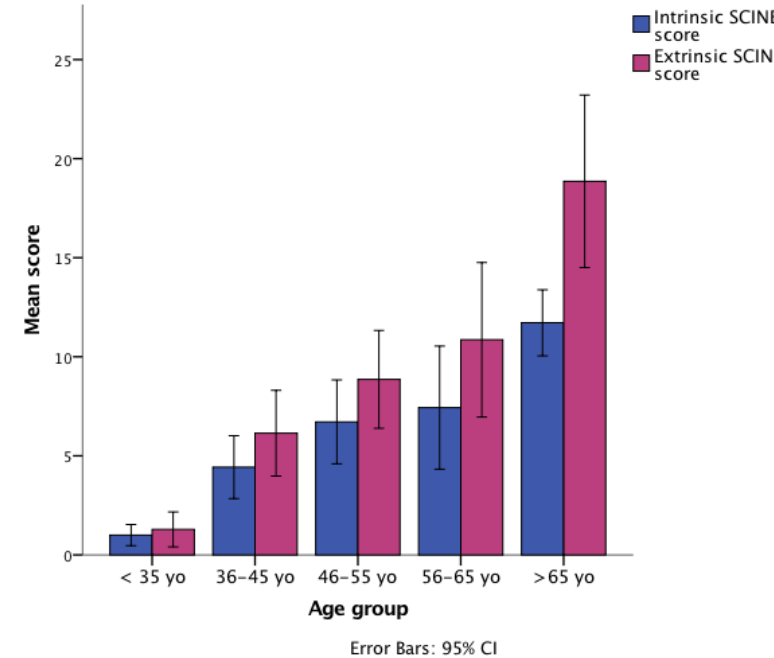
Figure 2. Intrinsic and extrinsic SCINEXA score differences between age groups. For the extrinsic score items, benign skin tumors, freckles, lentigines, pigment change, change of phototype, yellowness, pseudo-scars, coarse wrinkles, elastosis, telangiectasias, and permanent erythema differed significantly ( p -values ranging between < 0.01 and Table 4. Reflectance confocal microscopy parameters related to skin aging.